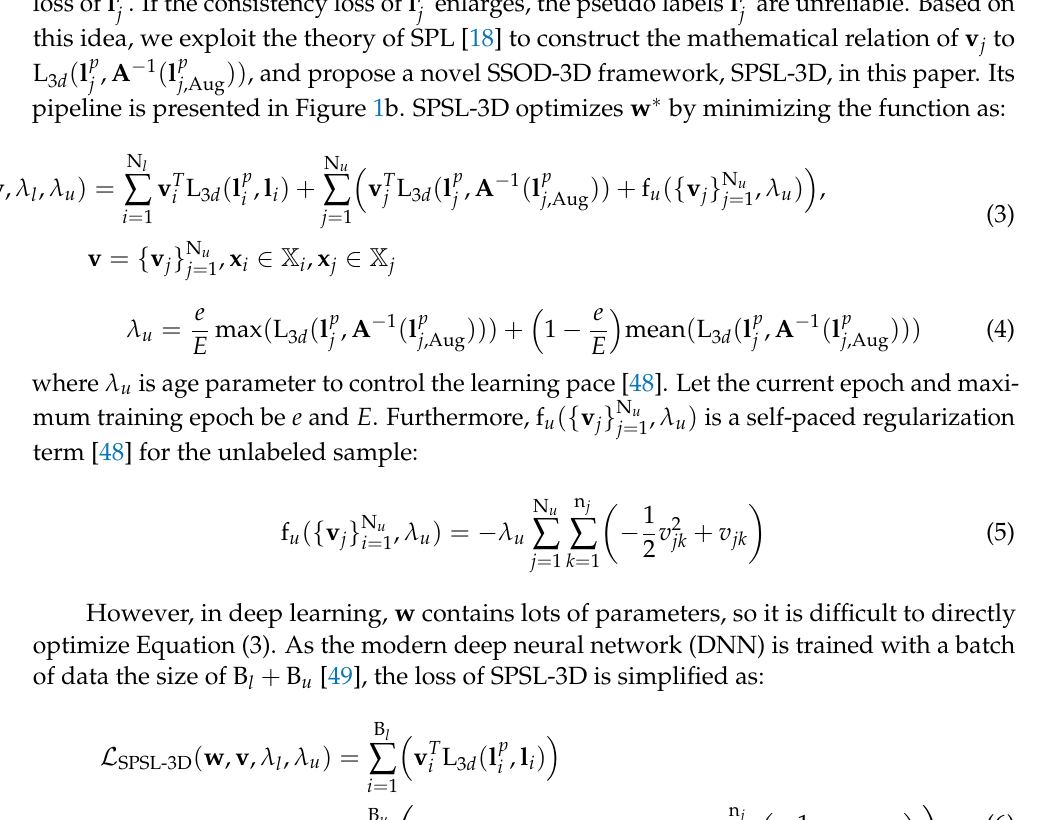
Figure 1. Difference between the previous SSOD-3D [10] and the proposed SPSL-3D. ( a ) Consistency loss [10]. ( b ) Loss in SPSL-3D. This emphasizes the quality of pseudo label l p bility weight of object in l p and thus enhancing the generalization ability of the baseline detector. j ( c ) Improvement of SPSL-3D in 3D object